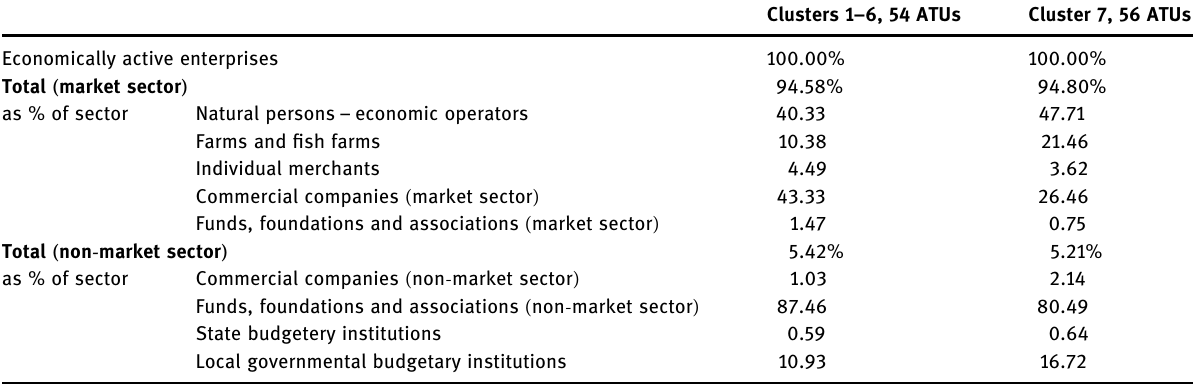
Table 5: Economically active statistical units broken down by kind,